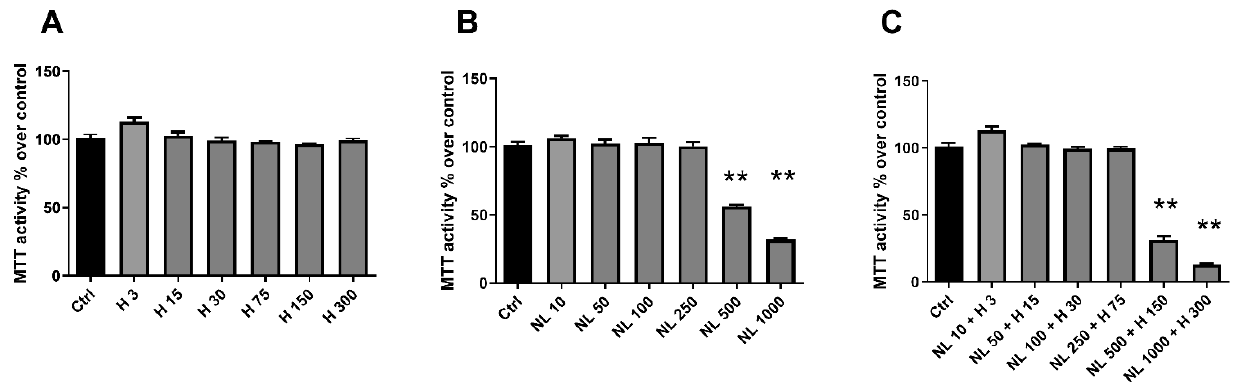
Figure 4. Evaluation of cell metabolic activity with increasing concentrations of hop extract, empty nanoliposomes, and nanoliposomes encapsulating hop extract in chondrocytes. Human chondro- cytes were exposed in vitro to increasing concentrations of ( A ) hop extract alone (3 to 300 µg/mL),